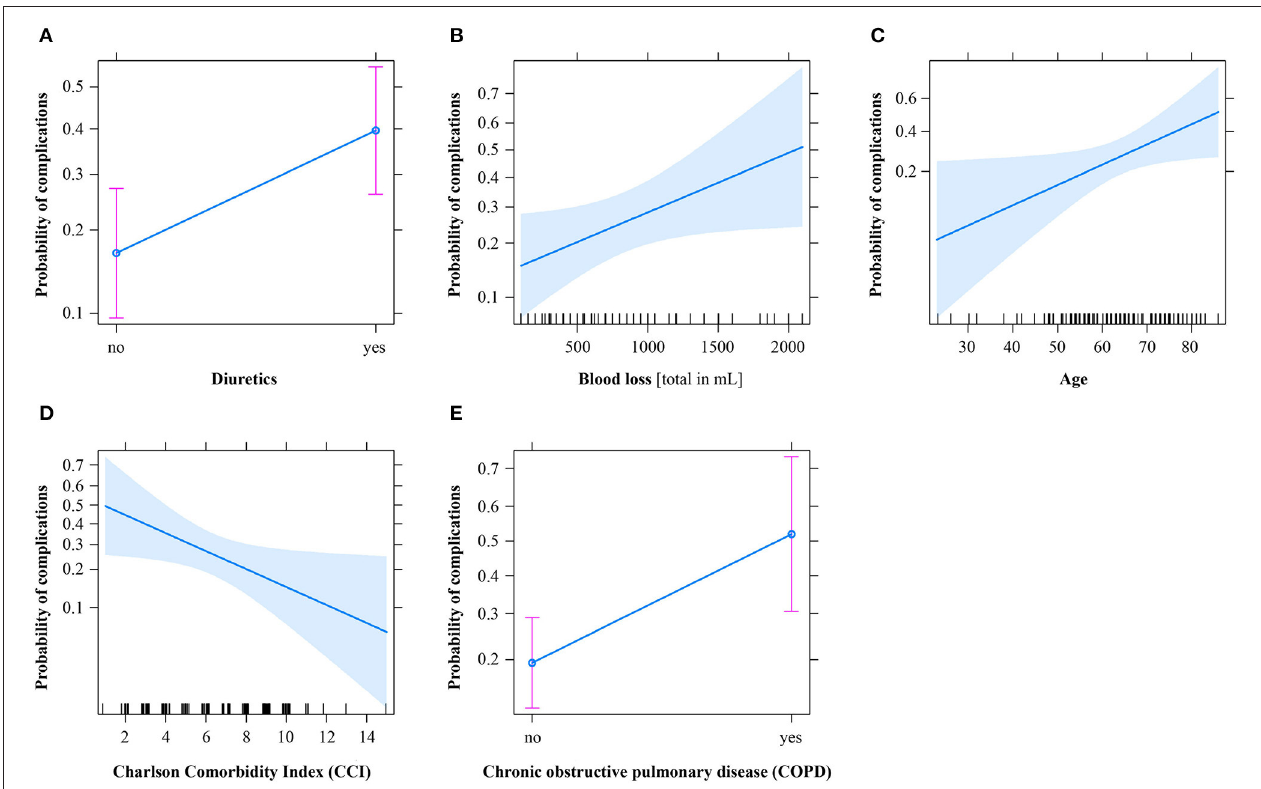
FIGURE 1 | Effect plots of the logistic regression model to predict the outcome “Relevant Systemic Complications.” Solid blue lines denote the mean predictions, and shaded blue bands or pink bars denote the 95% confidence interval. mL,